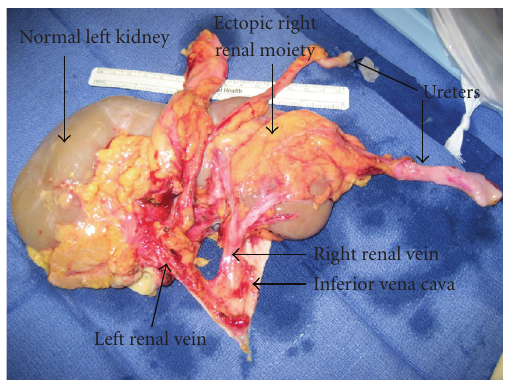
Figure 3: This intraoperative picture demonstrates the left kidney after transection, with the transected plane plegeted with fat and retention